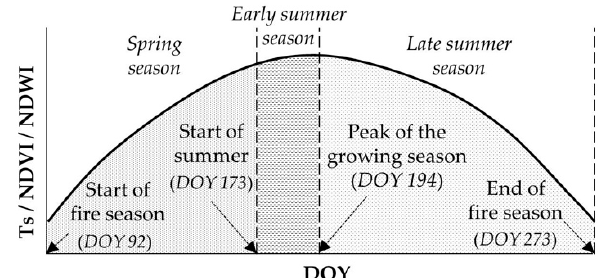
ff erent timelines of an entire fire